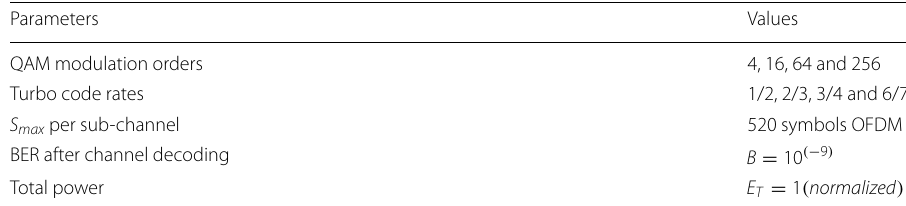
Table 2 Used parameters